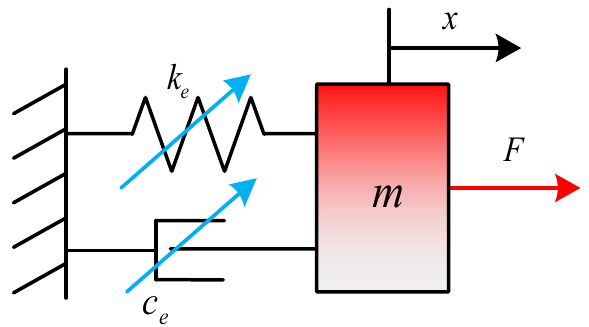
Figure 2. Equivalent dynamic model for a round link chain with n